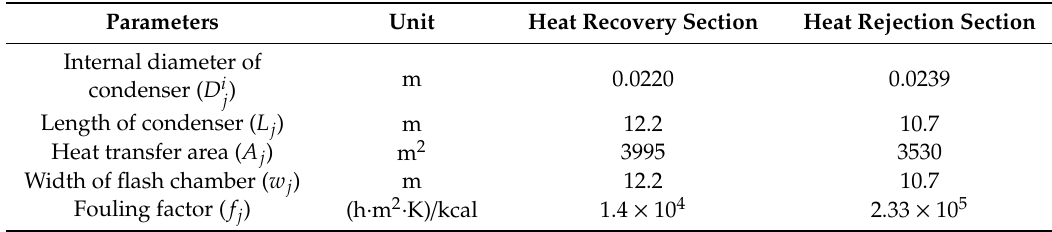
Table 2. Parameters of flash chamber of the MSF system.